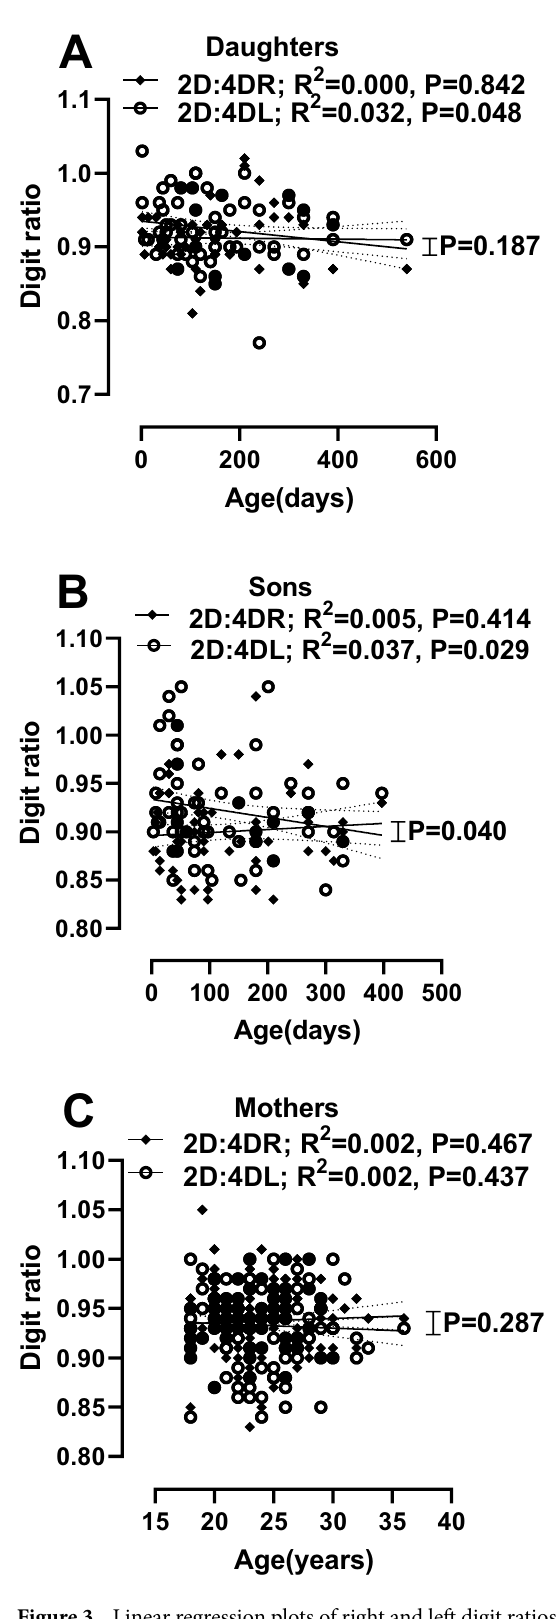
Figure 3. Linear regression plots of right and left digit ratios to age: linear regression of digit ratios to age among daughters ( A ), linear regression of digit ratios to age among sons ( B ), linear regression of digit ratios to age among mothers ( C